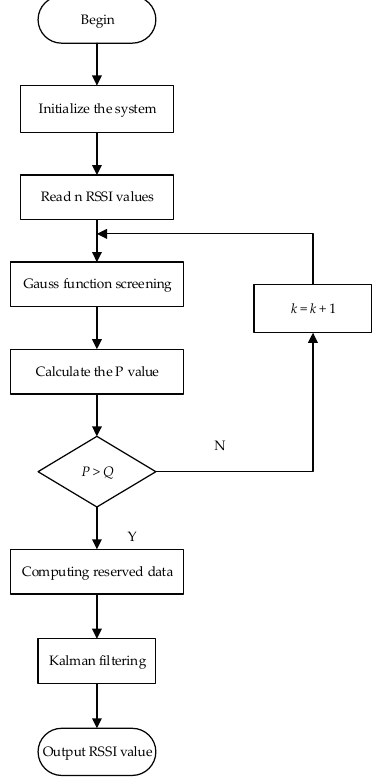
Figure 1. Flowchart of the Gaussian-Kalman filter algorithm.